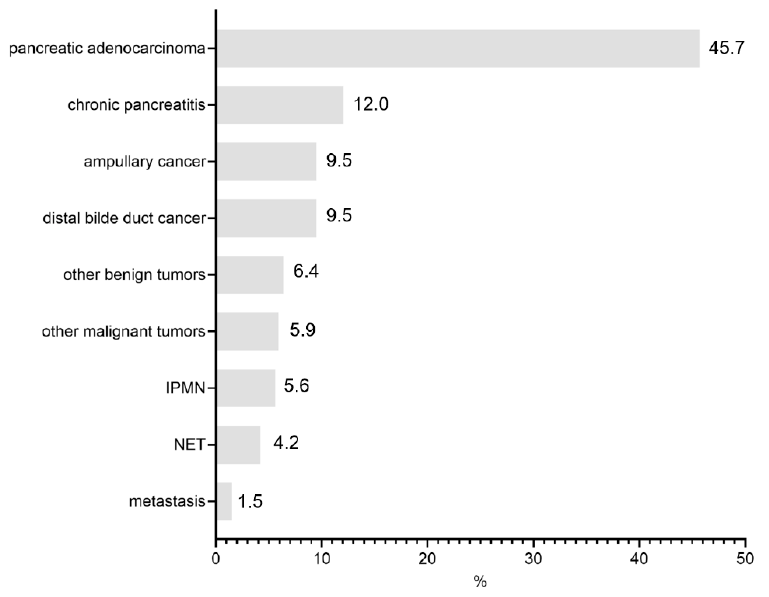
Figure 1. Indications for index operation.